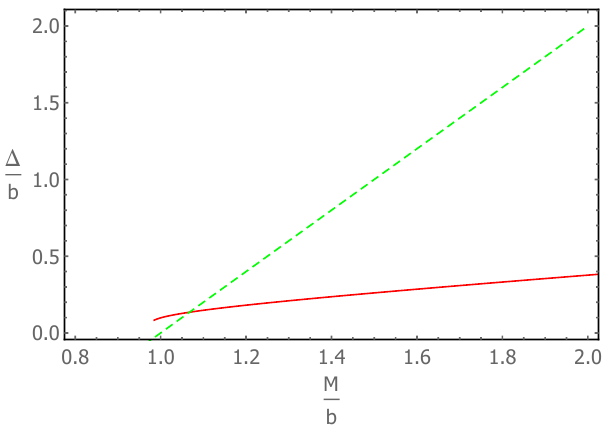
Figure 4 . The dependance of the width of the hard gap as a function of M=b in the holographic insulating phase (red) and weakly coupled (cid:12)eld theory (dashed